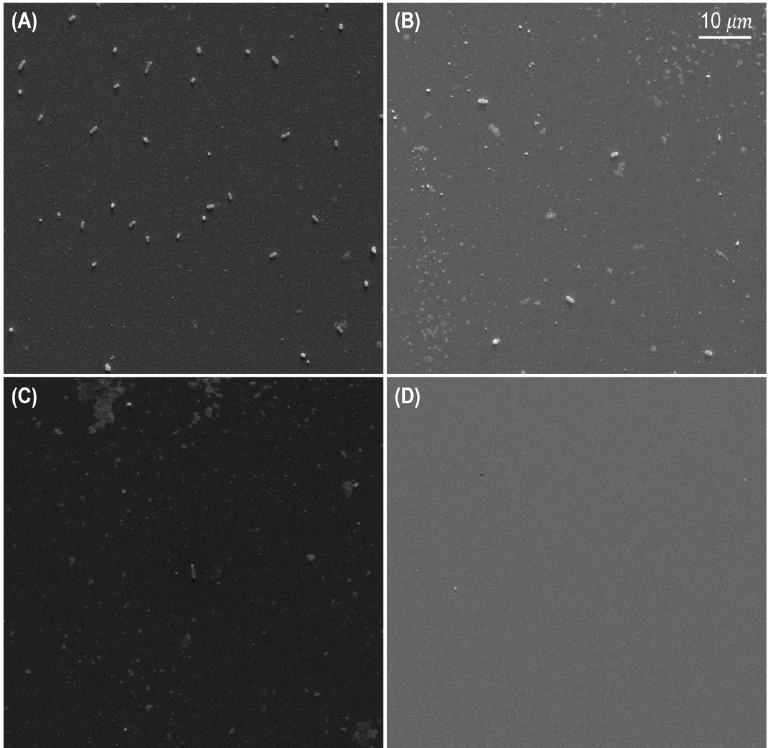
Figure 4. SEM images on the surface of QCM. Concentrations of Salmonella were ( A ) 10 9 CFU/mL, ( B ) 10 7 CFU/mL, ( C ) 10 5 CFU/mL, and ( D ) a clear quartz crystal surface, respectively. They were present on the surface with different populations.